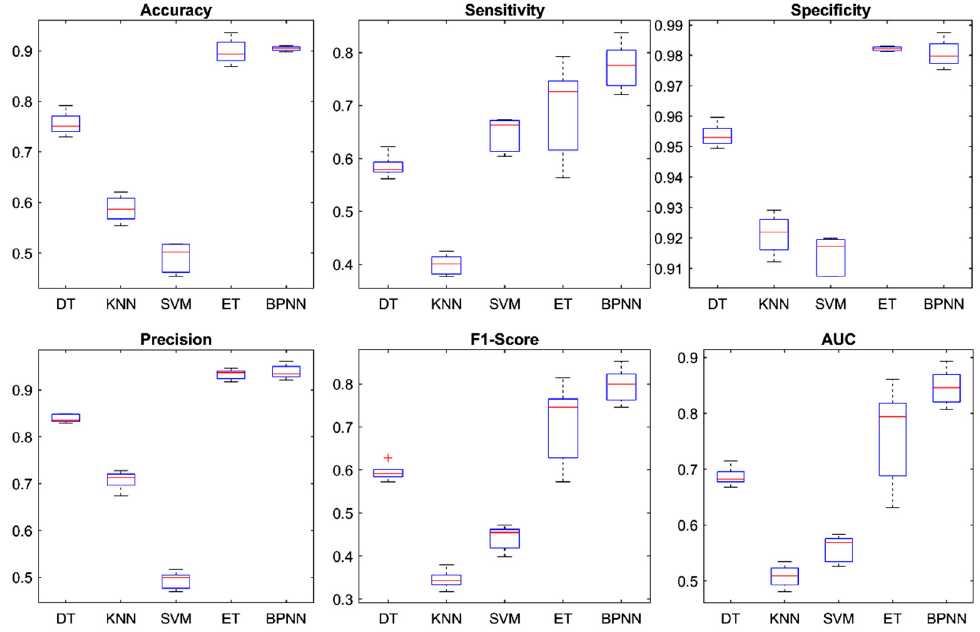
Figure 15. Second stage classification: Box-plot distributions of mean performance measurements for five alternative classifiers using repeated random trials.